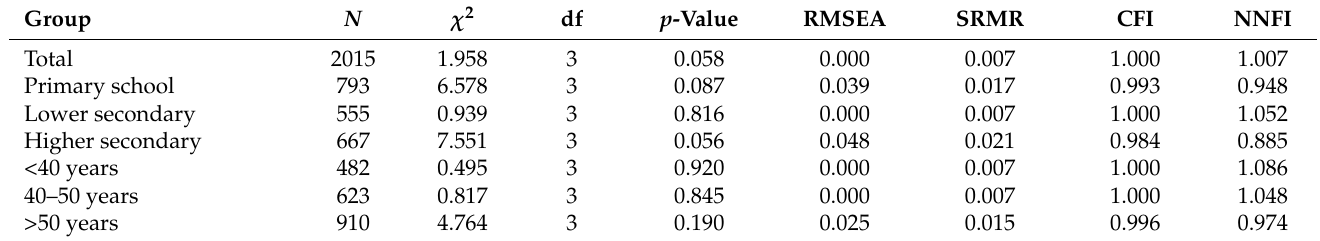
Table 3. Fit indexes of Model